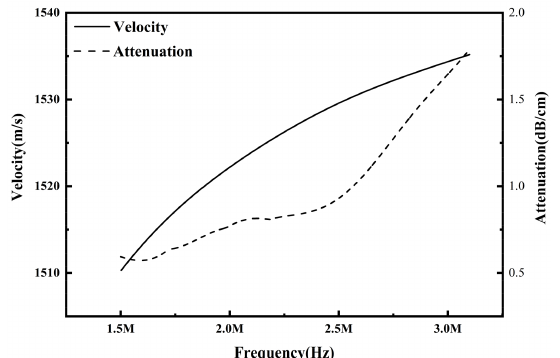
Figure 3. Measured frequency-dependent acoustic velocity and attenuation coefficient of the phantom